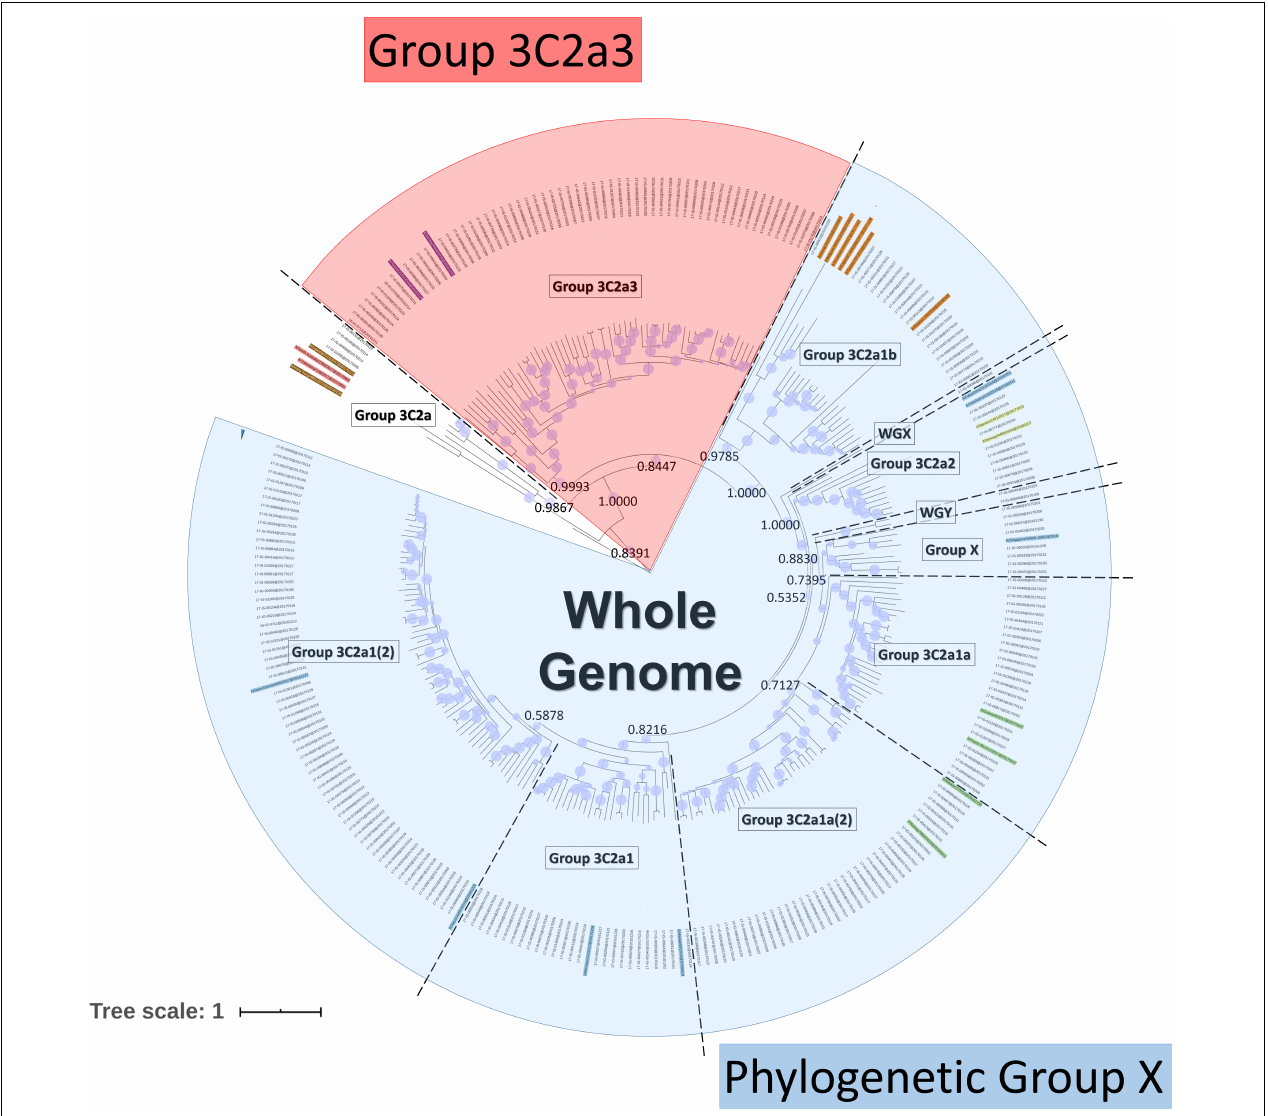
FIGURE 1 | Phylogenetic tree based on the whole H3N2 genome. Within the tree, the group labels represent the phylogenetic groups that were assigned to their respective samples according to their classification based on references (colored names) and the support of nodes by posterior probability values. Posterior probability values are indicated on key nodes that separate phylogenetic groups. The size of blue disks on nodes represents the posterior probability scaled between 0.5 and 1. The scale bar represents the average number of substitutions per site. Samples belonging to ‘Phylogenetic Group X’ are indicated in blue and those belonging to Group 3C2a3 in